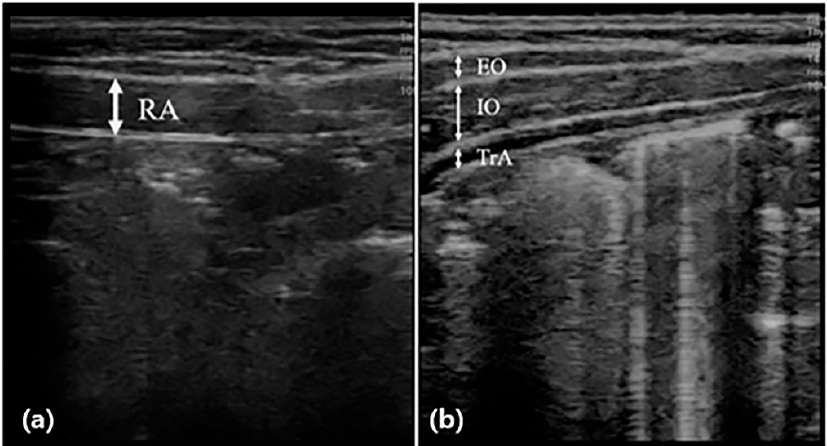
Figure 1. Measurement of abdominal muscle thickness through ultrasonography. The thickness of the rectus abdominal muscle (RA) was measured by placing the probe vertically ( a ), and the thicknesses of the external oblique (EO), internal oblique (IO), and transversus abdominis (TrA) were measured by placing the probe horizontally ( b ), and before and after the intervention.